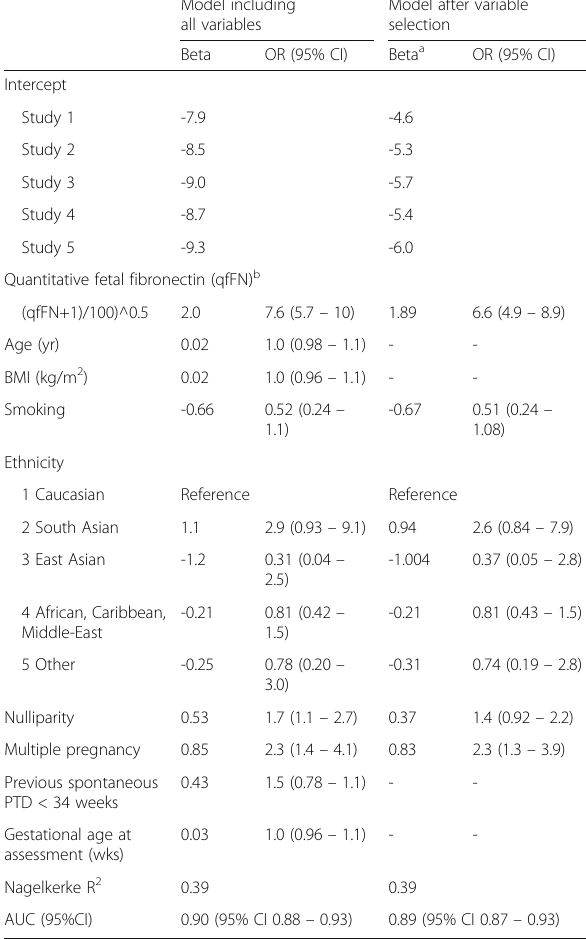
Table 1 (abstract P7). Multivariable models (before and after variable selection) for predicting spontaneous preterm delivery within